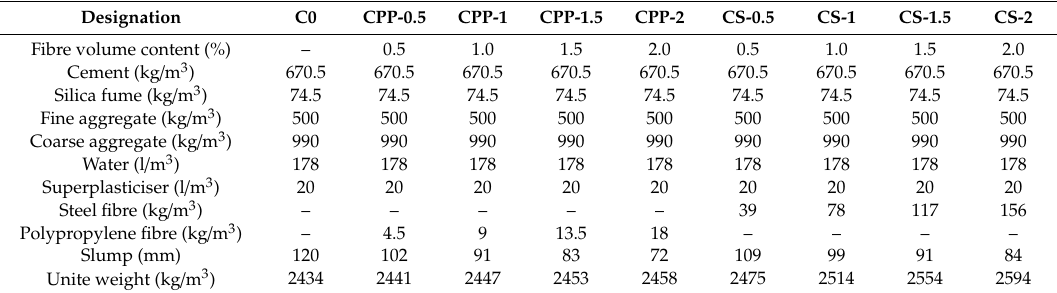
Table 3. Ultra-high performance concrete (UHPC) mixture proportion and properties of fresh concrete.